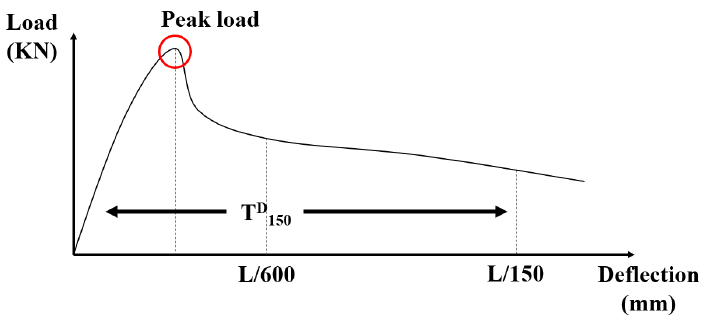
Figure 5. The flexural behavior of the steel fiber reinforced concrete.